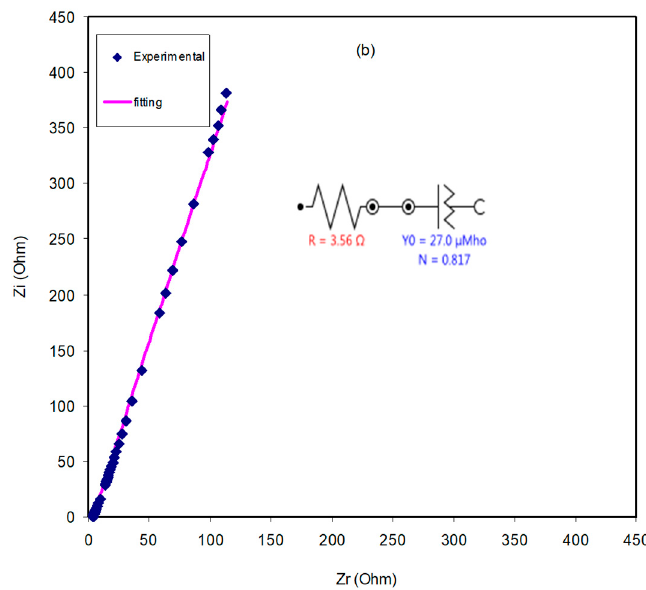
Figure 7. Experimental Impedance and fitting (EEC) plots for ( a ) CSDPB2 and ( b ) CSDPB4 blend electrolyte films.